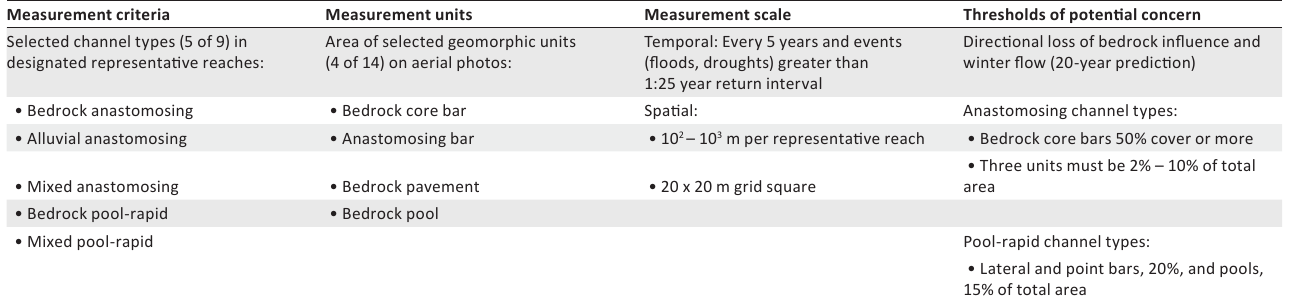
TABLE 5: The original geomorphology thresholds of potential concern proposed for the Sabie River, Kruger National Park, monitoring for the structural biodiversity components. Measurement